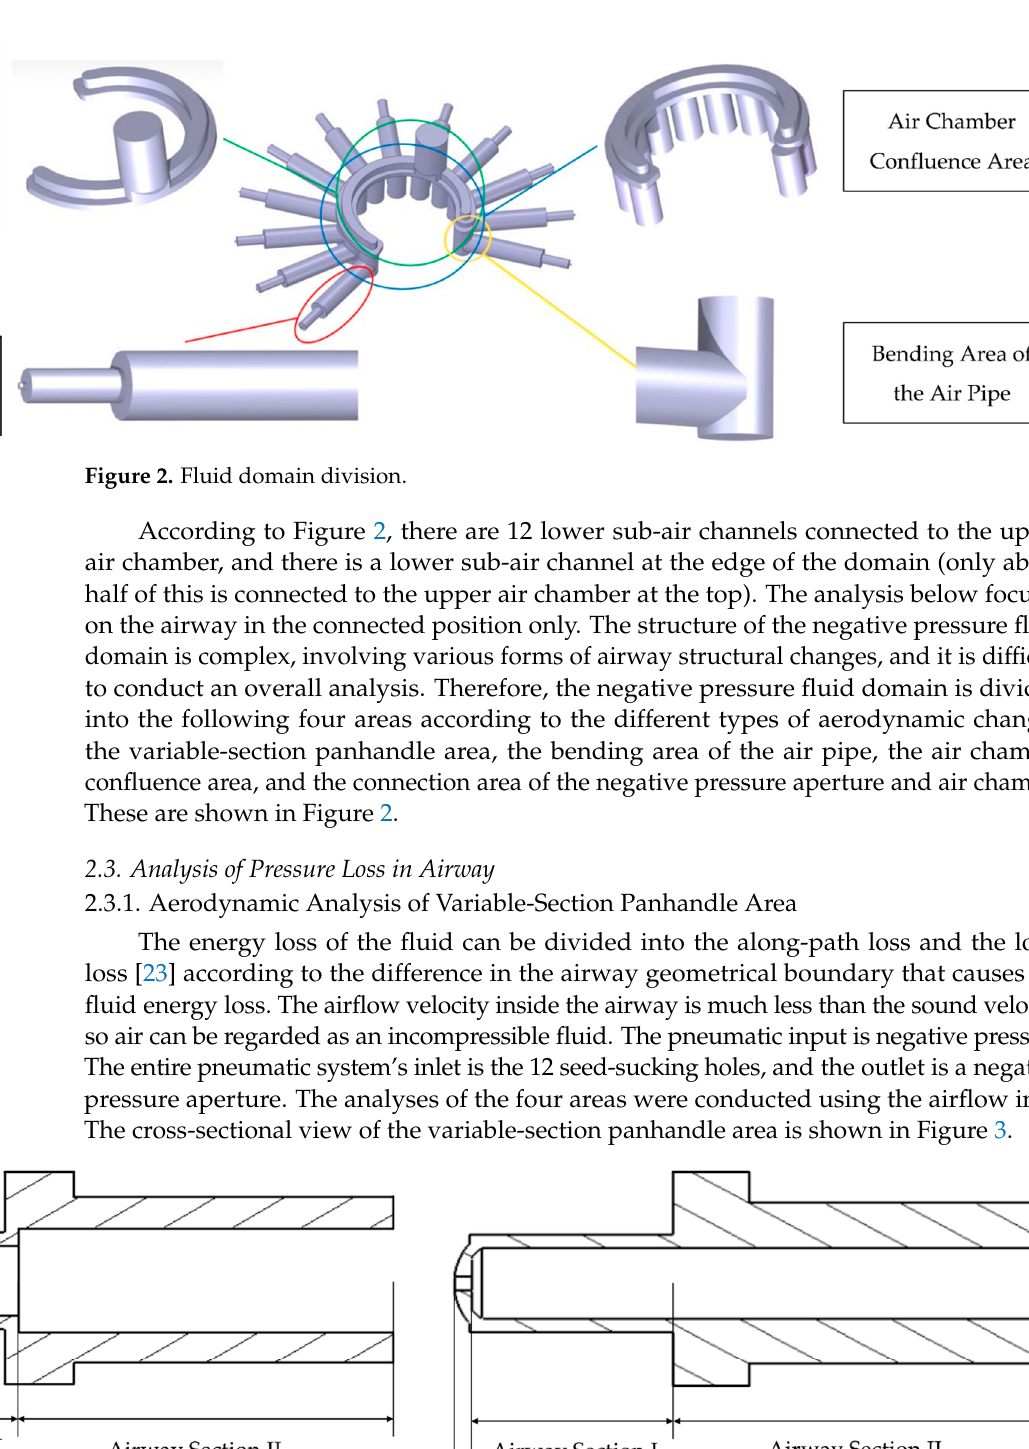
Figure 2. Fluid domain division.